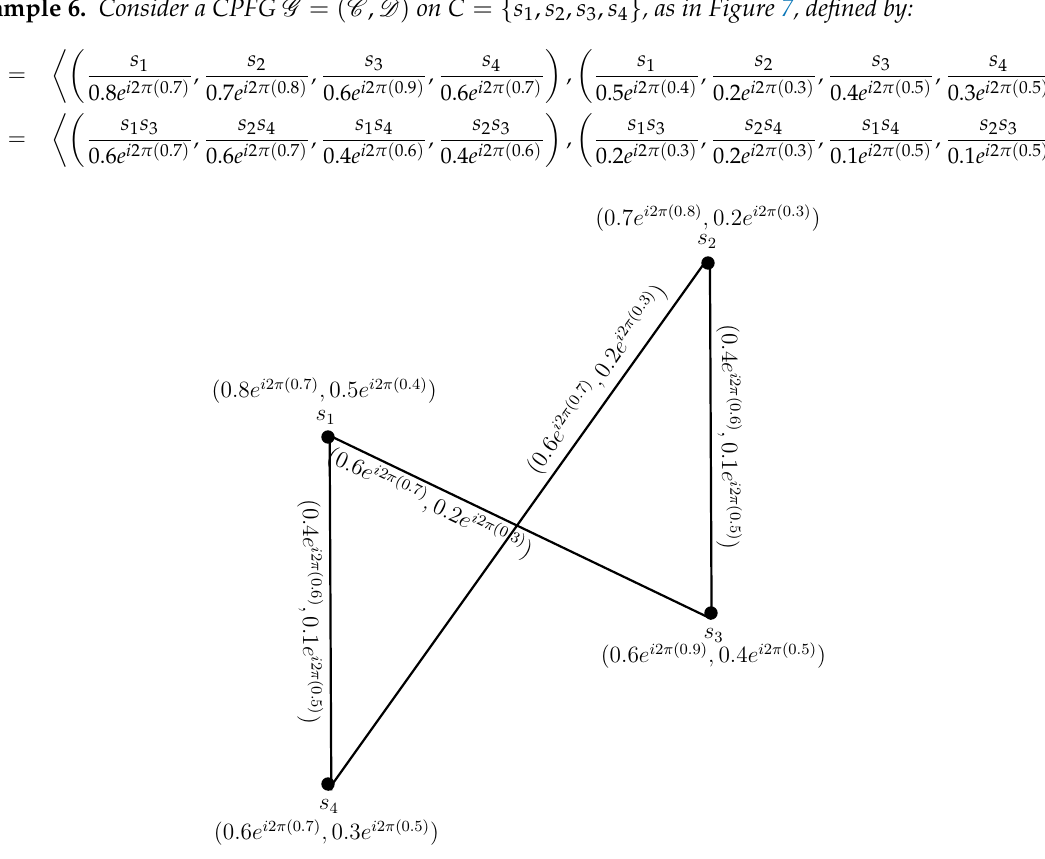
Figure 7. ( 1.0 e i 2 π ( 1.3 ) ,0.3 e i 2 π ( 0.8 ) ) -regular complex Pythagorean fuzzy Figure 7: (1 . 0 e i 2 π (1 . 3) , 0 . 3 e i 2 π (0 . 8) )-regular complex Pythagorean fuzzy graph.